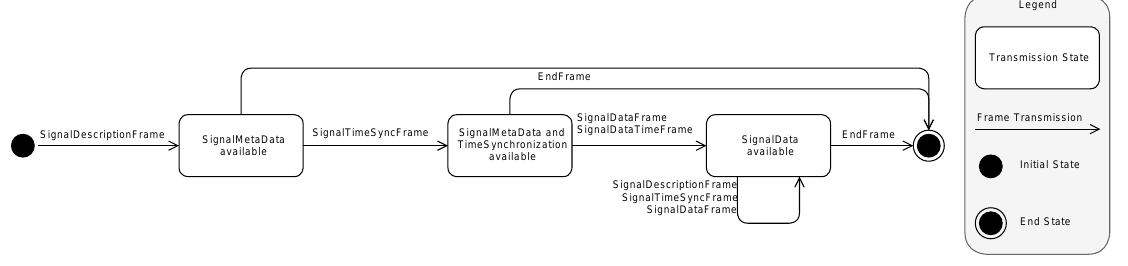
Figure 10. BTTM group state diagram.